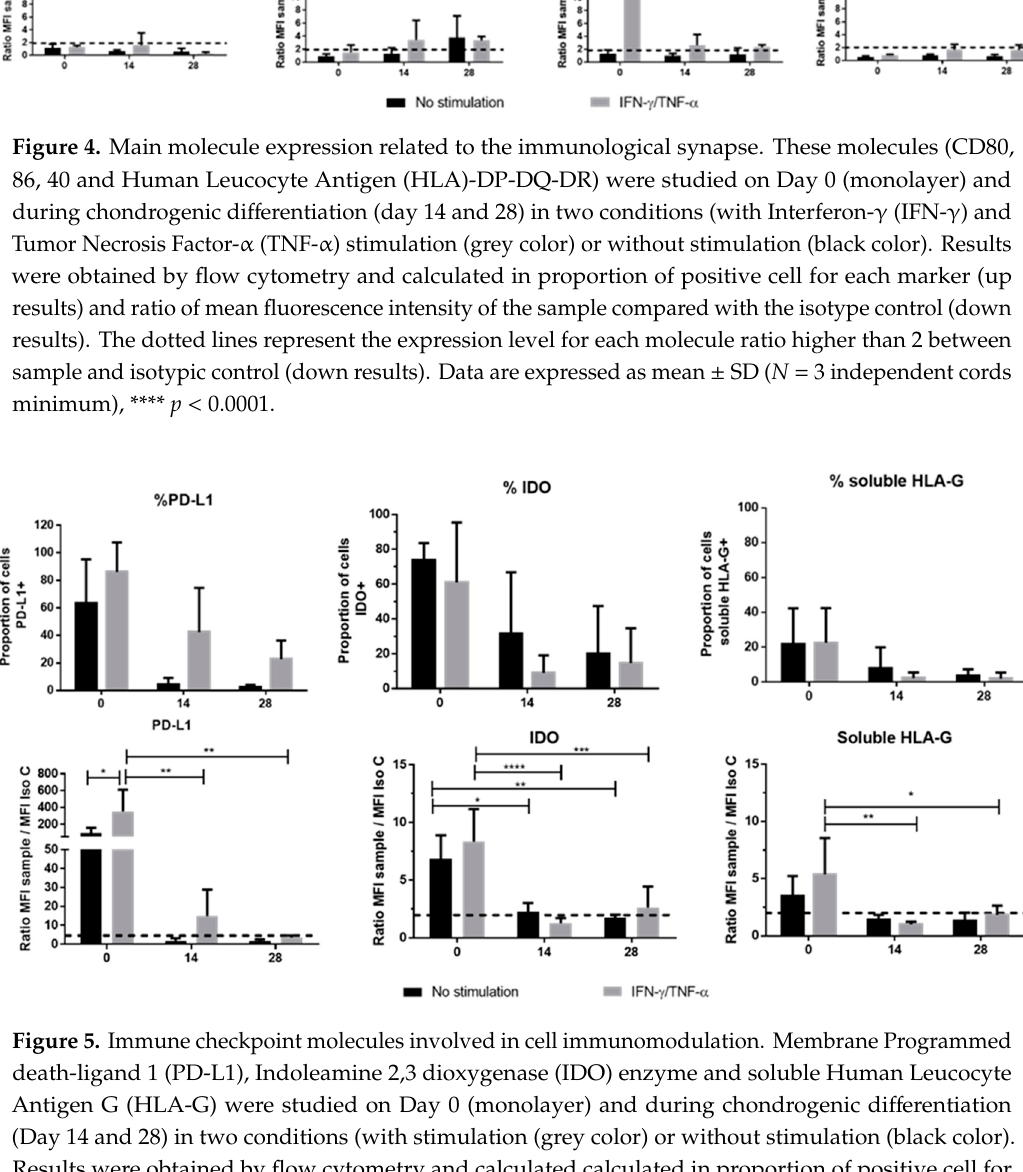
Figure 4. Main molecule expression related to the immunological synapse. These molecules (CD80, 86, 40 and Human Leucocyte Antigen (HLA)-DP-DQ-DR) were studied on Day 0 (monolayer) and during chondrogenic differentiation (day 14 and 28) in two conditions (with Interferon- γ (IFN- γ ) and Tumor Necrosis Factor- α (TNF- α ) stimulation (grey color) or without stimulation (black color). Results were obtained by flow cytometry and calculated in proportion of positive cell for each marker (up results) and ratio of mean fluorescence intensity of the sample compared with the isotype control (down results). The dotted lines represent the expression level for each molecule ratio higher than 2 between sample and isotypic control (down results). Data are expressed as mean ± SD ( N = 3 independent cords minimum), **** p < 0.0001.